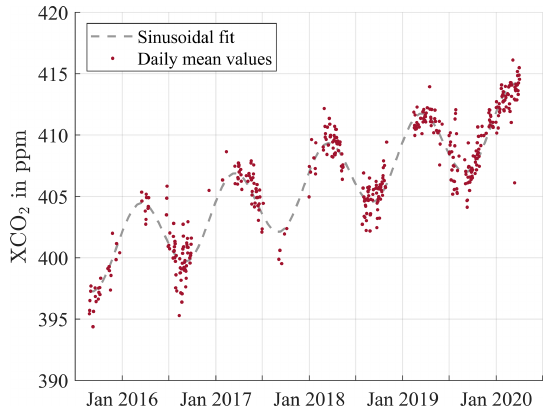
Figure 9. Daily mean values of the CO 2 measurements from the downtown station in Munich. The concentrations follow the glob- ally rising trend. Furthermore, the seasonal cycle with lower con- centrations in summer and higher concentrations in winter is clearly visible for the 5-year period